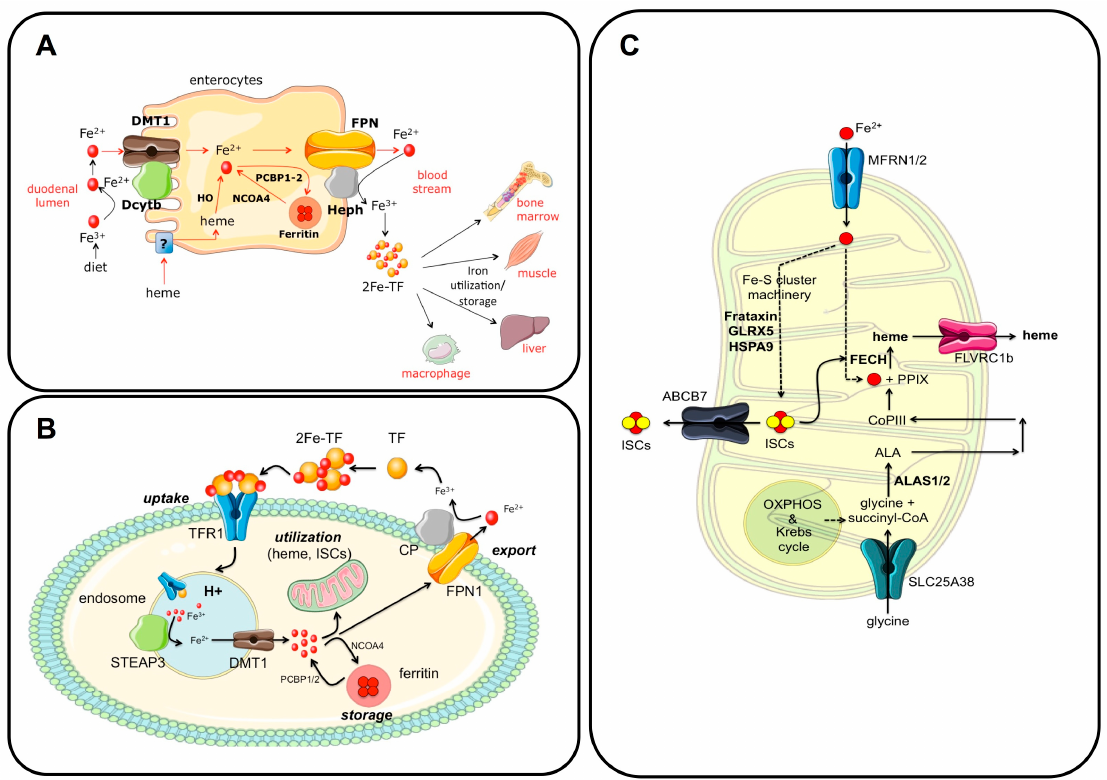
Figure 1. Regulation of iron absorption and utilization. ( A ) Iron homeostasis in enterocytes. The main players are depicted in the figure. Briefly, dietary iron is absorbed through DMT1 and DCytB,